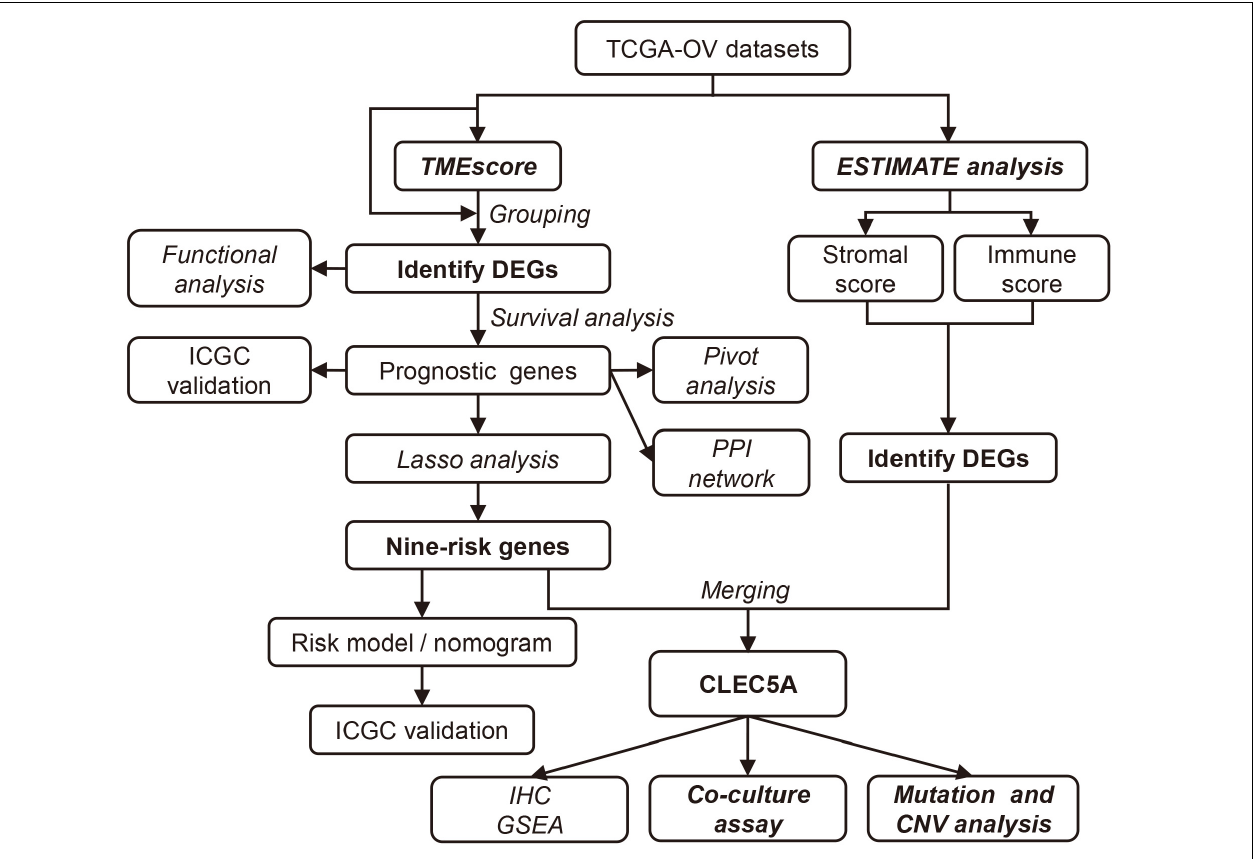
FIGURE 1 | The workflow of study